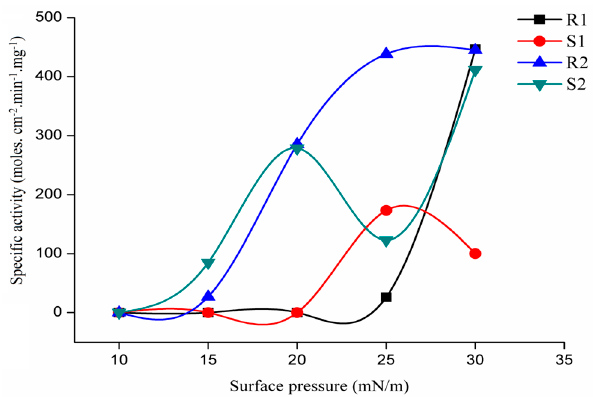
Figure 5. Variations with surface pressure on the catalytic activity of rGZEL using three pairs of pseudodiglyceride enantiomers (DDGs). Assays were carried out at room temperature. rGZEL was injected into the reaction compartment of a ‘‘zero-order’’ trough (volume, 2.5 mL; surface area, 12.56 cm 2 ). Buffer: 50 mM PB, pH 7.0. Activities were expressed as the number of moles of substrate hydrolyzed per unit time and unit reaction compartment area per milligram of enzyme in the ‘‘zero-order’’ trough (moles cm − 2 min − 1 mg − 1 ). R1, 2,3-Didecanoyl-2-Deoxyamino-1-O-Methyl Glycerol (2,3DDG), with the R Configuration; S1, 1,2-Didecanoyl-2-Deoxyamino-3-O-Methyl Glycerol (1,2DDG), with the S Configuration; R2, 1,3-Didecanoyl-1-Deoxyamino-2-O-Methyl Glycerol